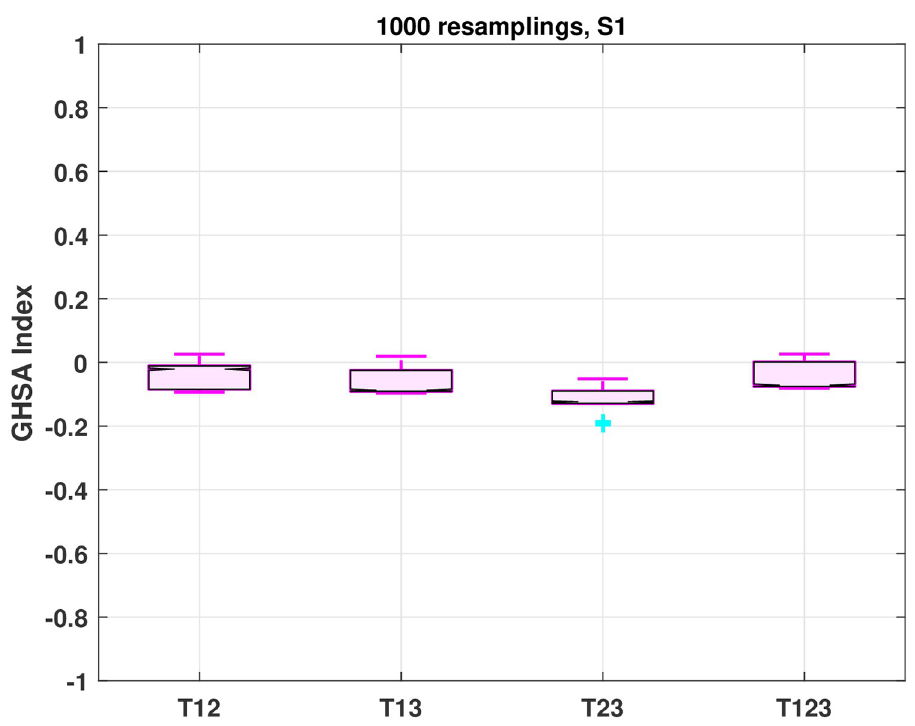
Fig 5. GHSA analysis for stimulation S 1 and N v = 10 3 validation datasets. All four combination treatments T 12 , T 13 , T 23 , T 123 are shown on the x-axis. Each combination treatment is represented by a box plot showing the minimum value, 25 th , 50 th , 75 th percentiles and maximum value of all N v GHSA indices obtained during a resampling-based leave-one-out validation